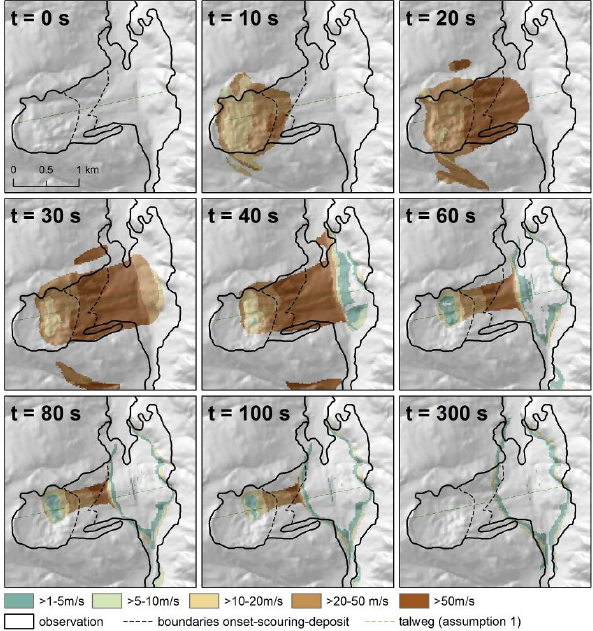
Fig. 6: Time series of flow depth distribution simulated with φ = 35° and δ = 22° at a cell size Fig. 6. Time series of flow depth distribution simulated with φ = of 20 m. Only flow depths >1 m are shown. 35 ◦ and δ = 22 ◦ at a cell size of 20m. Only flow depths > 1m are shown. Table 4. Correspondence of observed and modelled rock avalanche